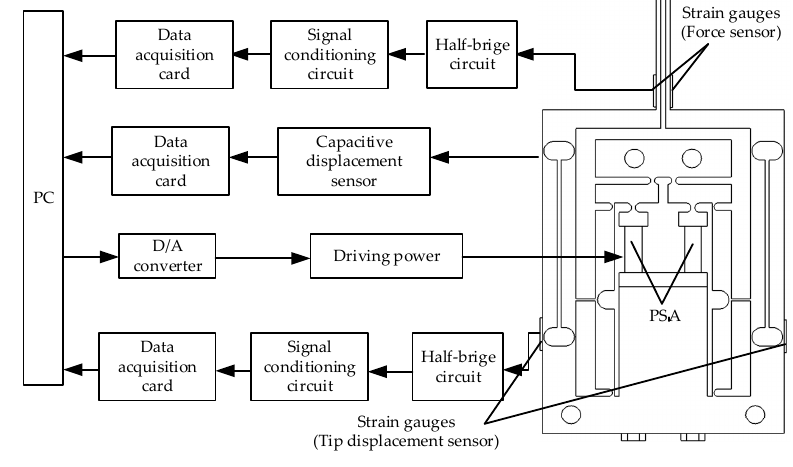
Figure 6 . Experimental test system.